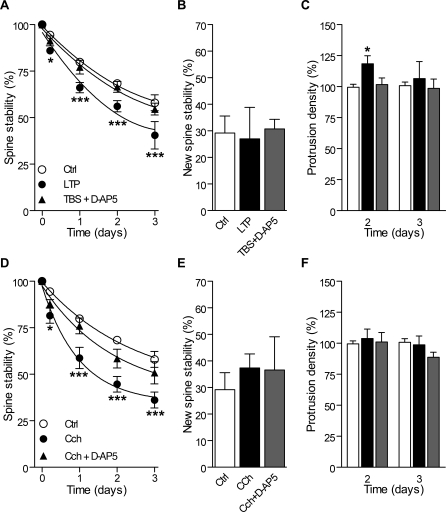
Changes in Spine Stability and Protrusion Density Induced by Theta Burst Activity(A) Stability of pre-existing spines measured as the proportion of initial spines still present 5 h, 1, 2, and 3 d later in control slices (n = 20/557), in slices following LTP induction (n = 8/220) and in slices stimulated with TBS + D-AP5 (n = 7/301). Filopodia were not considered because they are essentially transient.(B) Stability of the new spines formed during an interval of 5 h and still present 2 d later under control conditions, following LTP induction or TBS + D-AP5.(C) Changes in protrusion density (spines and filopodia) measured after 2 and 3 d in control slices (open columns), following LTP induction (black columns) and following TBS + D-AP5 (grey column).(D–F) Same as in (A), (B), and (C), respectively, but following Cch treatment (1 h, 10 μM; n = 11/328) or Cch + D-AP5 (n = 10/353).*p < 0.05, ***p < 0.001; two-way ANOVA with Bonferroni post-tests.